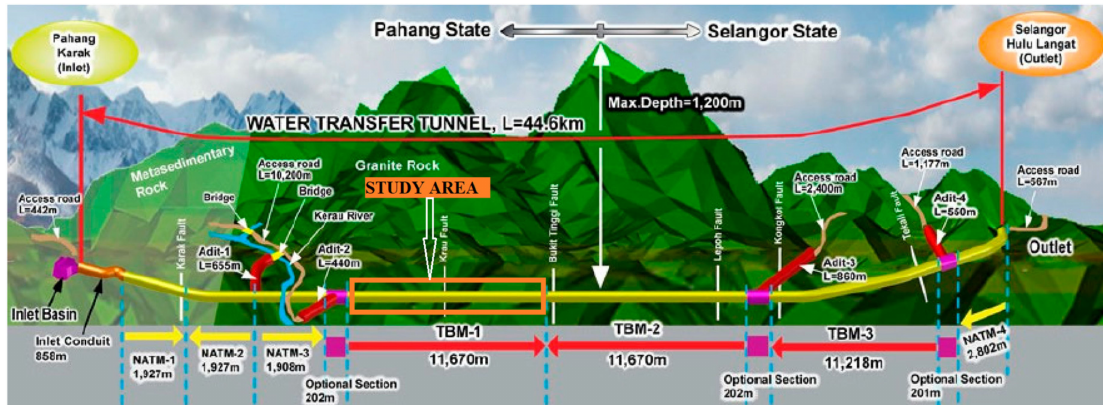
Figure 3. Schematic cross section of the tunnel